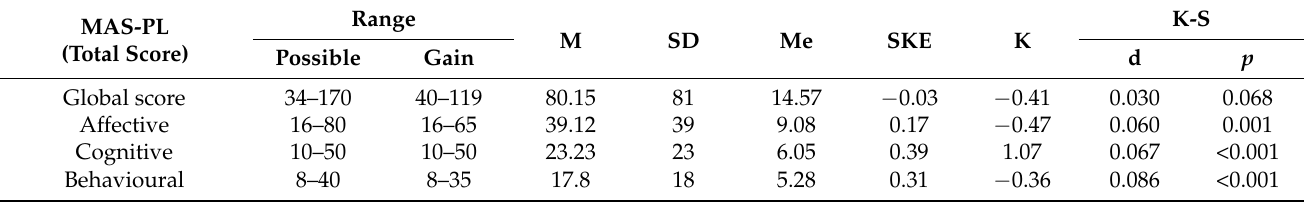
Table 2. Descriptive analysis of results (N = 625).